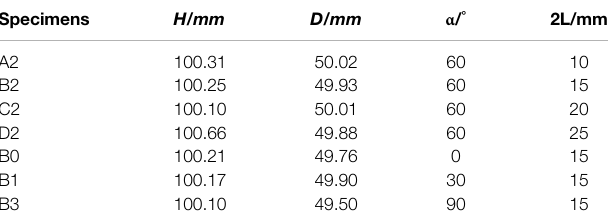
TABLE 1 | Physical properties of sandstone